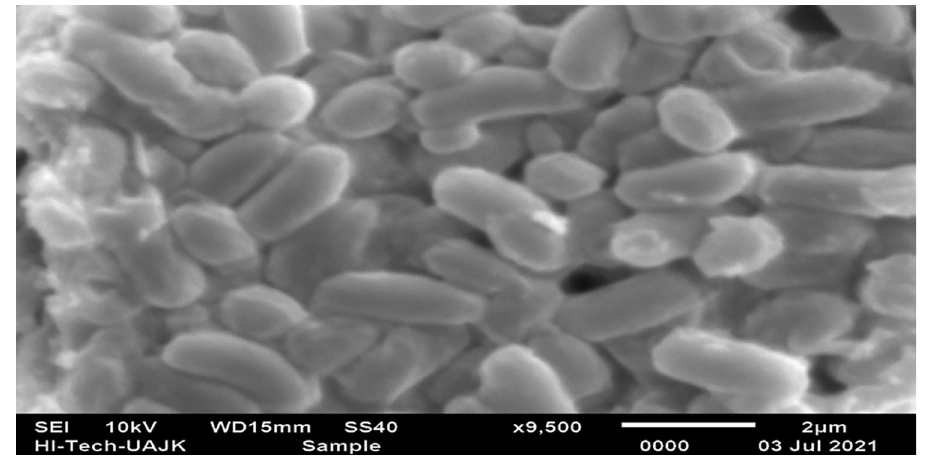
Fig 3. SEM micrograph of B . cereus NC7401, the 24 h old cells that were grown in nutrient broth medium in a shake flasks system.